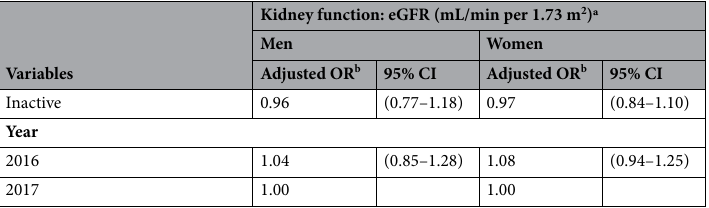
Table 2. Odds ratio for decreased kidney function. ªModification of Diet in Renal Disease estimated glomerular filtration rate for Korean population (mL/min per 1.73 m 2 ) = 107.904 × (Creatinine in mg/ dL) −1.009 × (age) −0.02 × 0.667 [if female]. b OR adjusted for all sociodemographic, economic, health-related factors considered in the study. Q1: < 4.80 mg/dL, < 3.70 mg/dL; Q2: 4.80–5.49 mg/dL, 3.70–4.19 mg/dL; Q3: 5.50–6.09 mg/dL, 4.20–4.79 mg/dL; Q4: 6.10–6.99 mg/dL, 4.80–5.99 mg/dL; Hyperuricemia: ≥ 7.00 mg/ dL, ≥ 6.00 mg/dL, respectively. d BMI body mass index; Obesity status defined by BMI based on 2018 Clinical Practice Guidelines for Overweight and Obesity in Korea. e Three groups (white, pink, blue) based on the International Standard Classification Occupations codes. Unemployed group includes